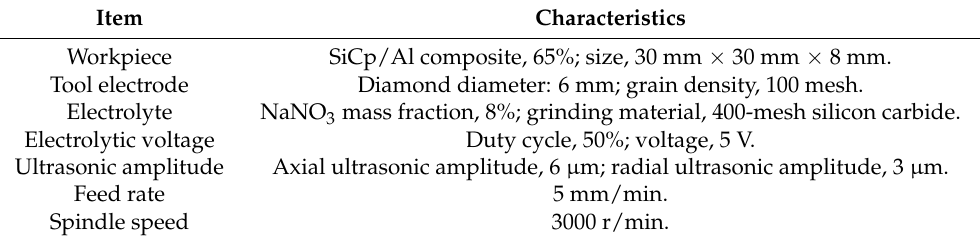
Table 1. Material parameters.